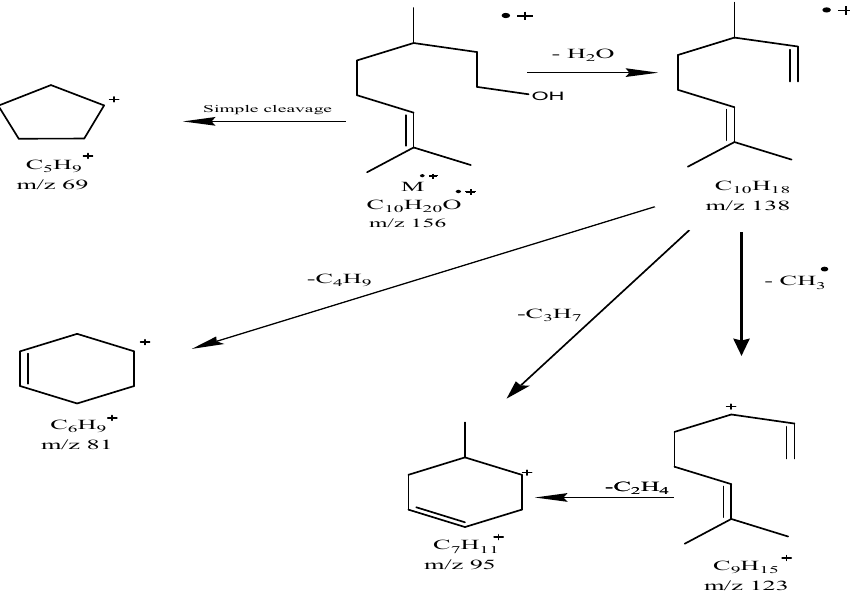
Figure 2. Fragmentation pattern of citronellol under electron ionization 70